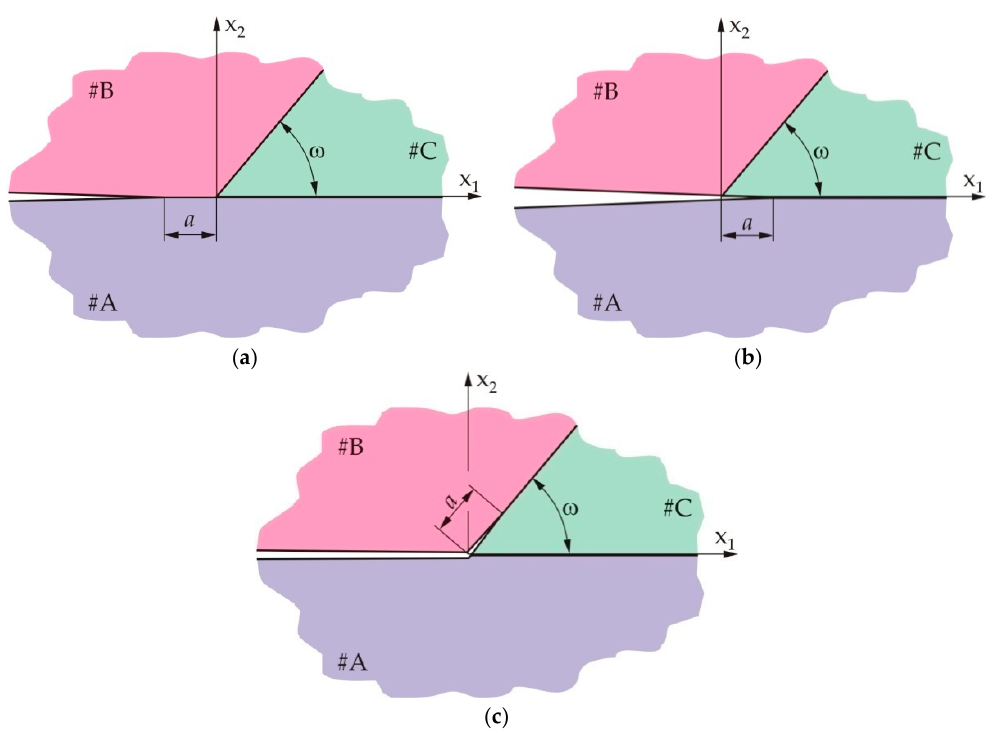
Figure 1. ( a ) Interface crack approaching a three-material joint; ( b ) crack propagating along the AC interface; ( c ) crack deflecting into the BC interface.